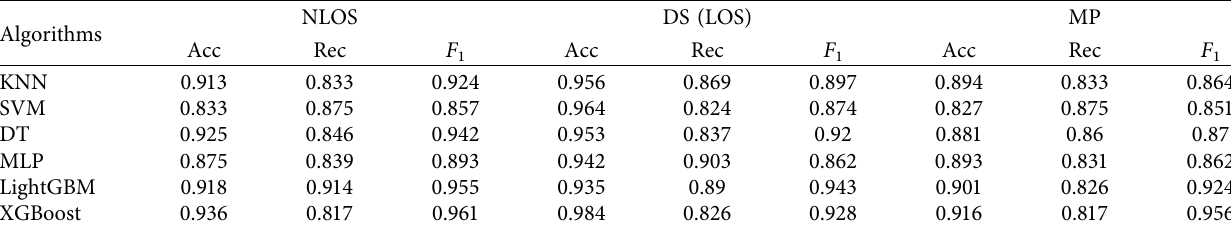
Table 2: The results comparison of classical classification methods.